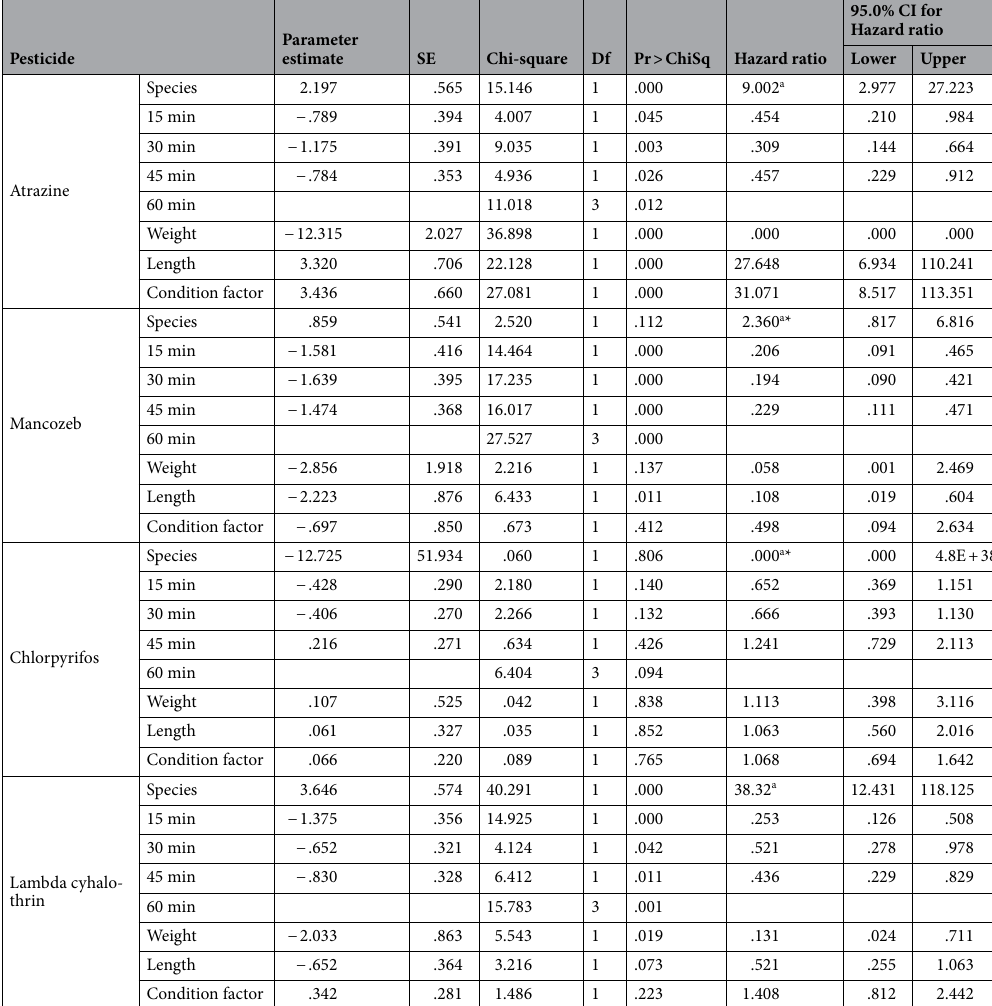
Table 7. Cox PH model summary of all predictors on survival of fingerlings. a Increase in hazard ratio, while b indicates decrease in hazard ratio compared with when other predictors where held constant. *Significant when other predators were held constant but no longer significant. + Not significant when other predators were held constant and not significant now. # Not significant when other predators were held constant but now